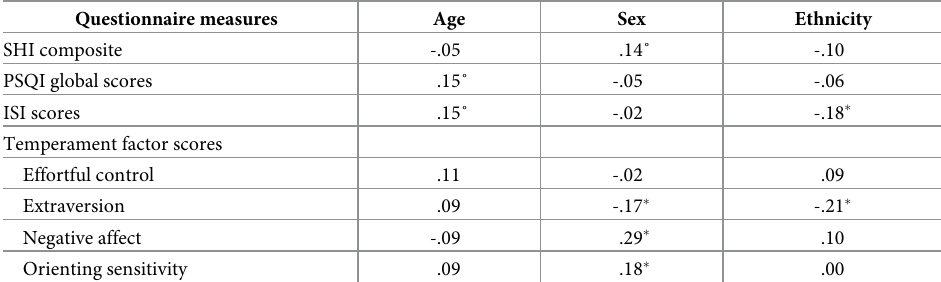
Table 2. Correlations conducted to identify potential covariates (N = 167).